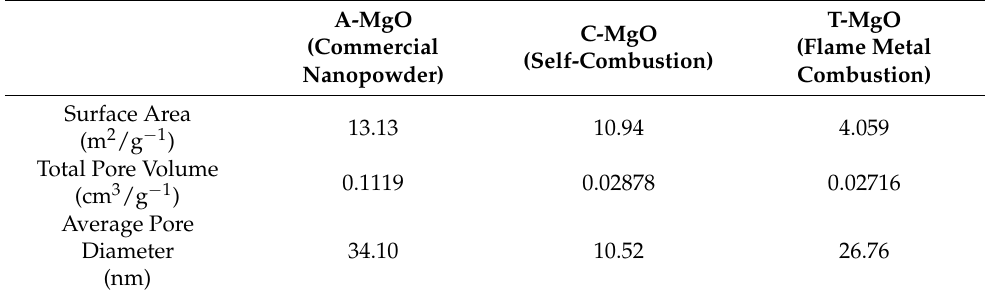
Table 1. Physical characteristics of three pristine MgO nano-adsorbents measured by BET method (Four significant